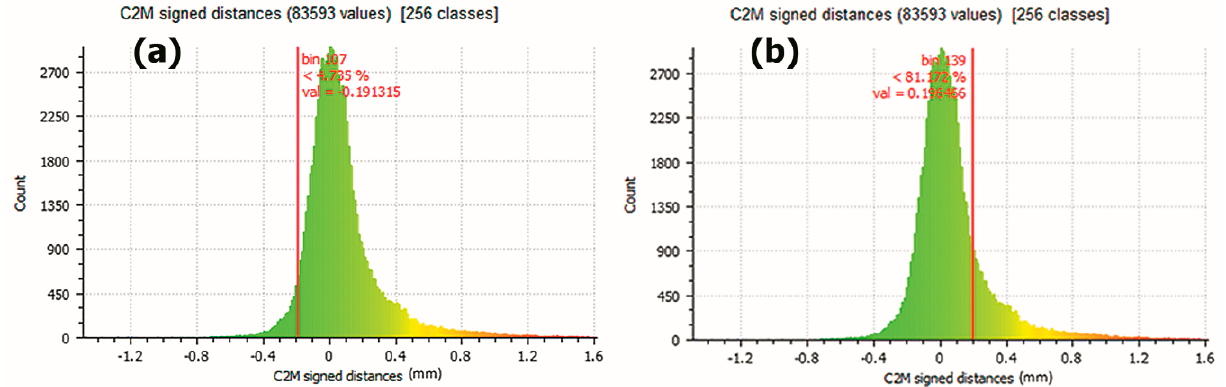
Figure 16. ( a ) Results showing that 18.828% of the points have a larger difference than 0.2 mm. ( b ) Results showing that 4.735% of the points have a smaller difference than − 0.2 mm. (Source: self-made).